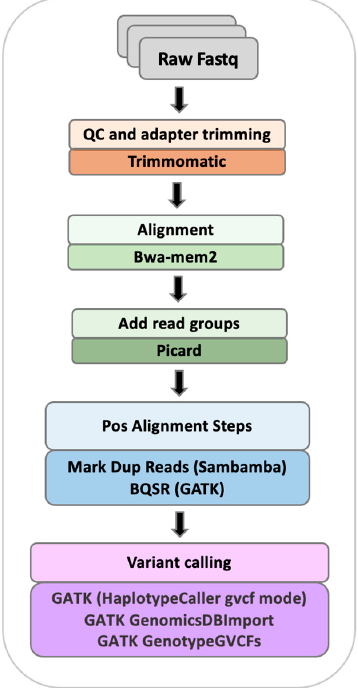
Figure 1. IVDP pipeline for variant calling from Illumina whole-genome short sequencing reads.